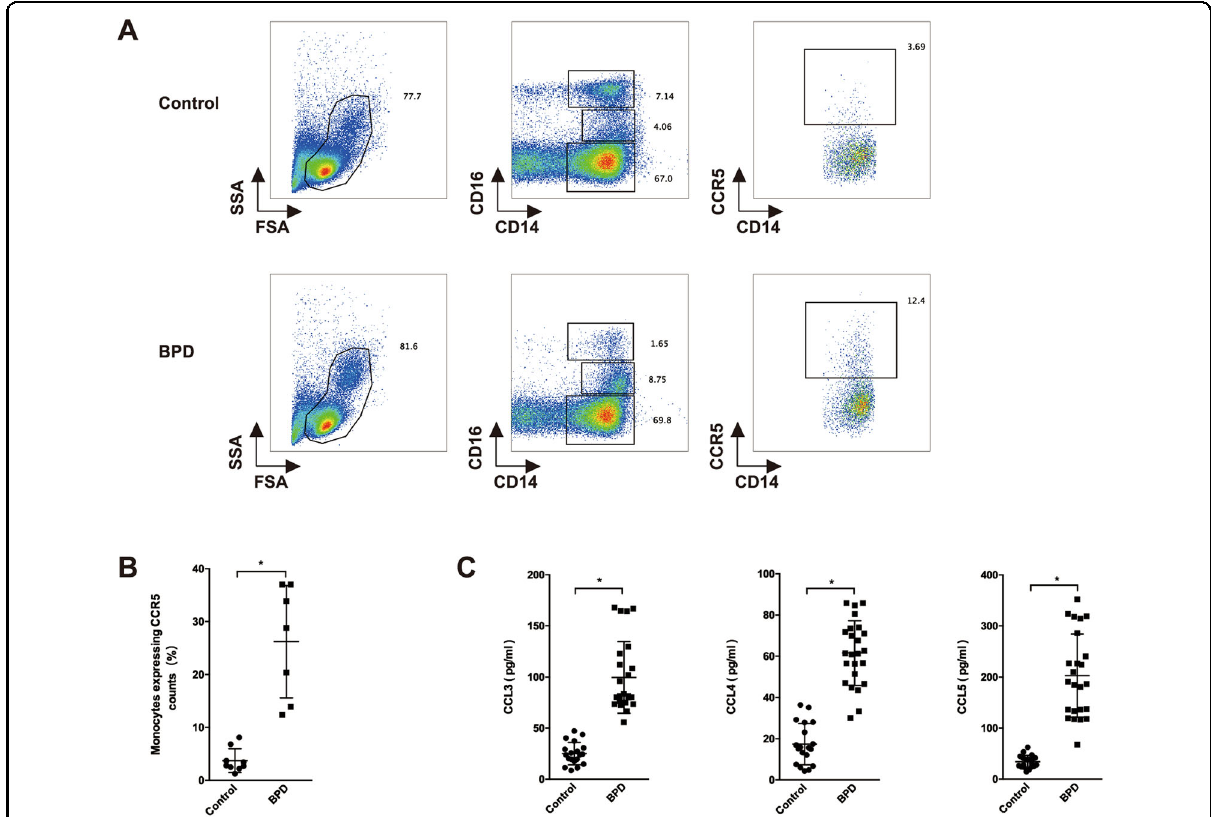
Fig. 8 CCR5 and its ligands were upregulated in infants with BPD. A Representative fl ow plot of CCR5-expressing CD14 + CD16 + monocytes in control infants ( n = 9) and infants with BPD ( n = 7). B Quantitative analysis of the percentage of CCR5-stained CD14 + CD16 + monocytes. C Plasma CCL3, CCL4, and CCL5 levels in control infants ( n = 19) and infants with BPD ( n = 24). * p <